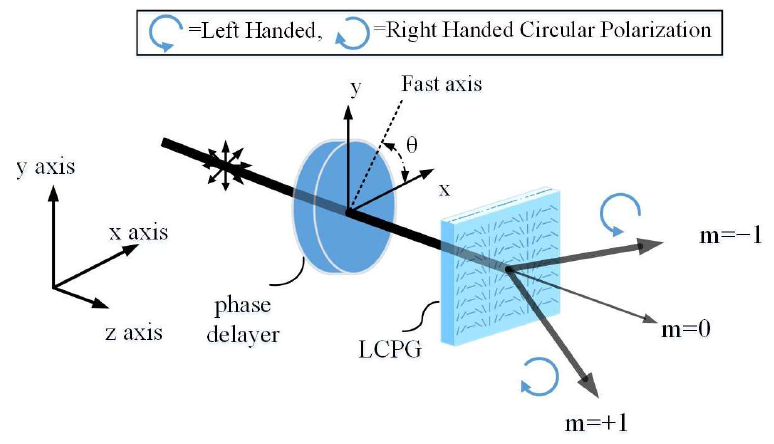
Figure 1. Schematic diagram of LCPG-based polarization detection module. The PG employed here has a cycloidal distribution of birefringence, which is realized by photo-aligned liquid crystal (LC) polymers [25–27]. It acts as a thin-film polarization- dependent beam splitter, which separates the left-/right-handed circular polarization component of the incident light into ± 1 diffraction orders. The ± 1 orders exhibit orthogonal circular polarization states, and the diffraction efficiency can be described as follows